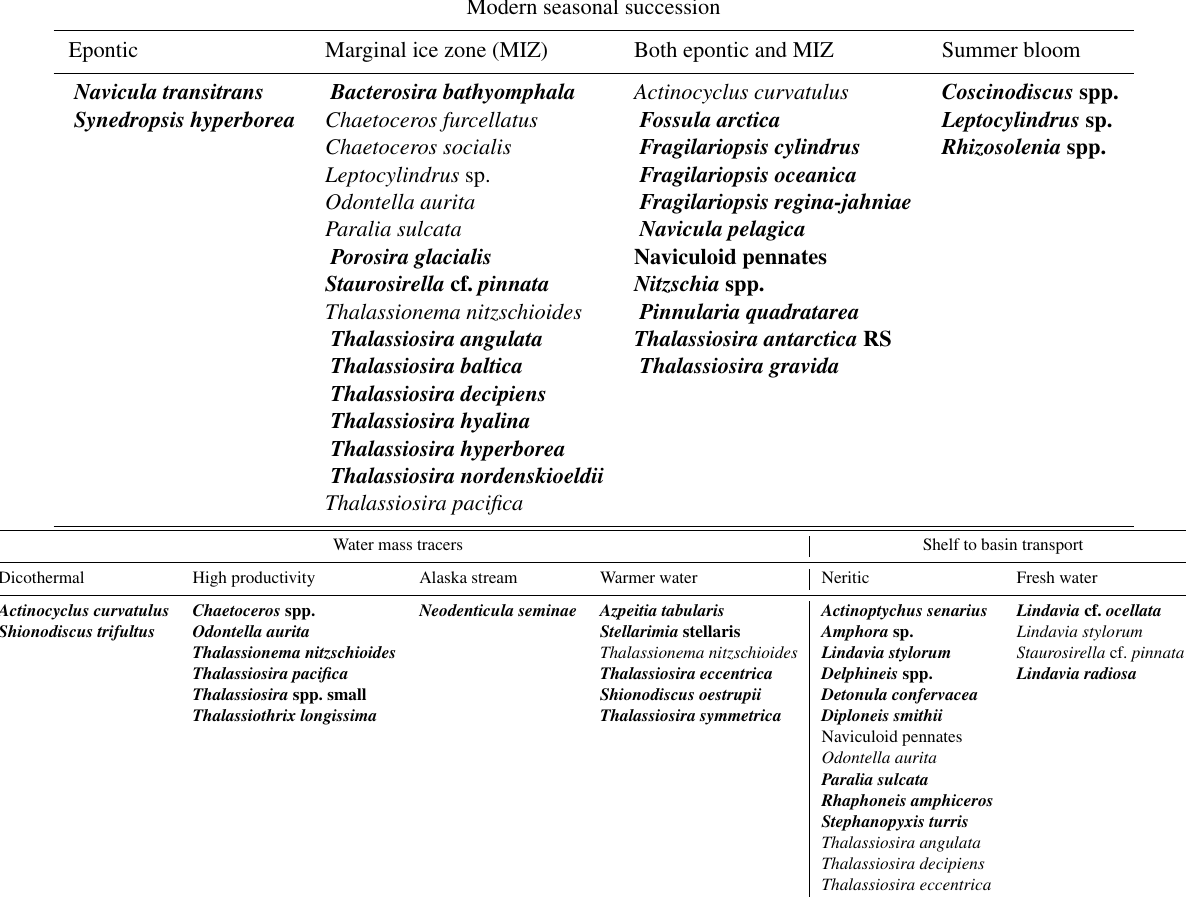
Table 3. Bering Sea diatom species grouped by environmental niche. In cases where a species appears in more than one niche, the grouping used in this study is highlighted in